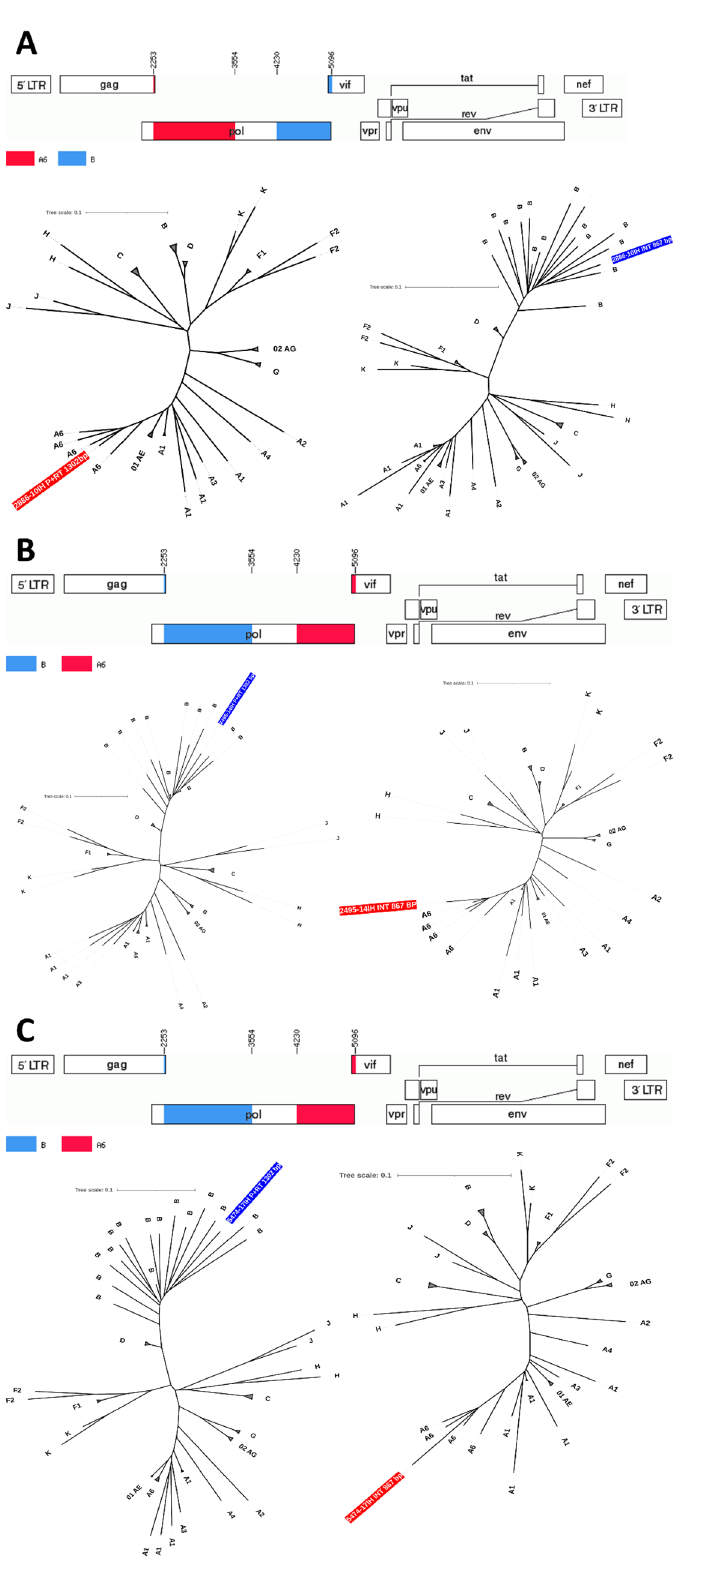
Figure 2. Three unique recombinant form genome maps and the separate phylogenetic ML trees with the corresponding partial protease/reverse transcriptase and integrase sequences confirming the subtype assignment. For the tree reconstruction a dataset obtained from HIV sequence compendium 2018 was used. Multiple branches for the same subtype were collapsed. A. sequence 2886 acquired in the city of Warsaw, B. sequence 2495 acquired in the city of Krakow, C. sequence 5474 acquired in the city of